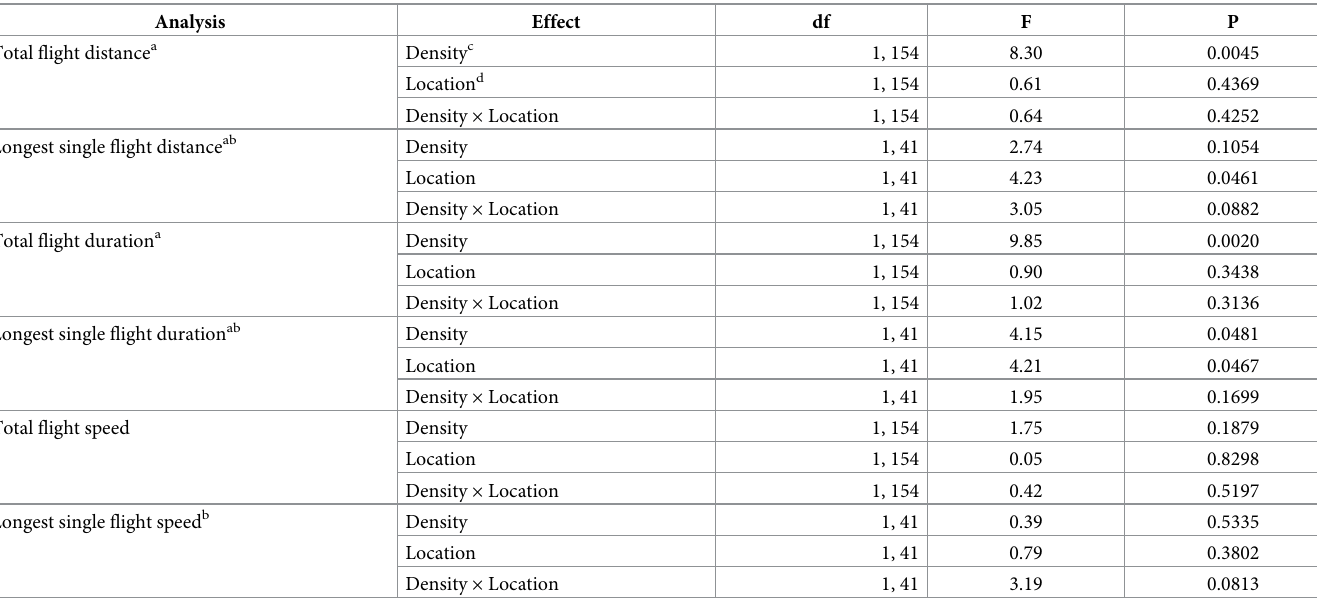
Table 2. Analyses of variance for flight data from the voluntary flight